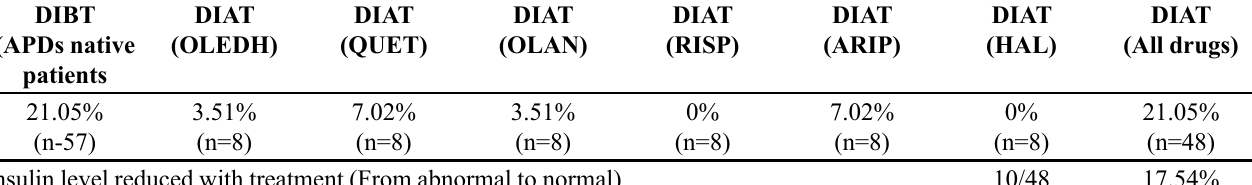
TABLE II - Per cent wise distribution of patients with disturbed ( > 26.5 µIU/mL) insulin levels before and after exposure to antipsychotic treatment